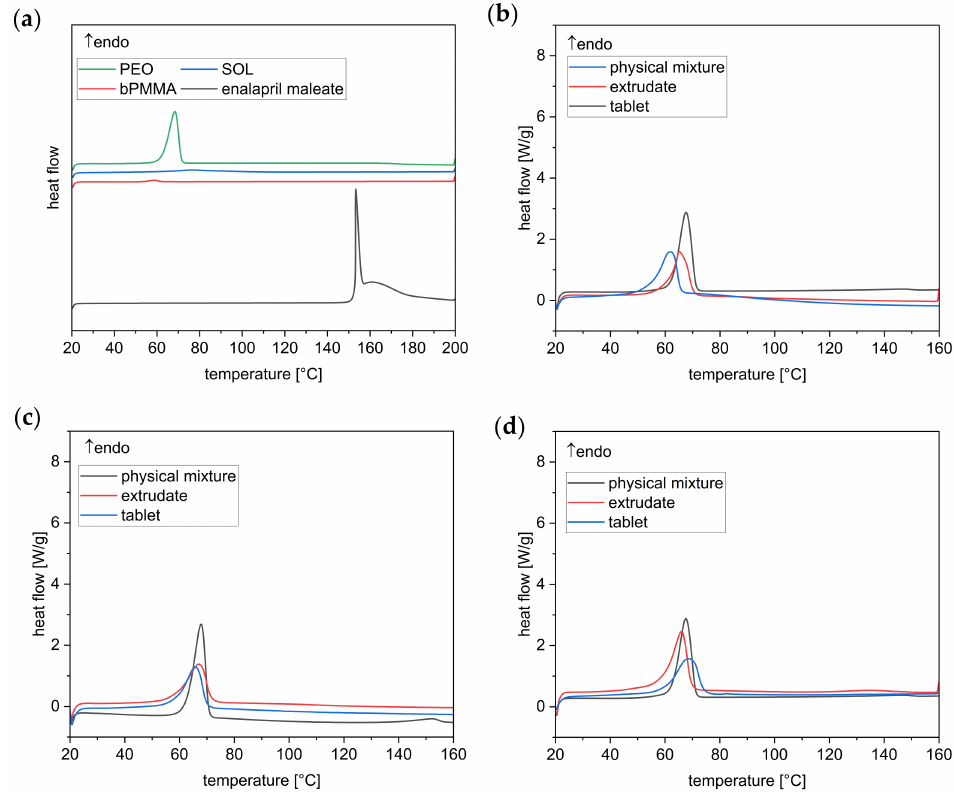
Figure 3. DSC thermograms of the starting materials ( a ), the formulation containing SOL extruded at 100 ◦ C ( b ), the formulation containing bPMMA extruded at 100 ◦ C ( c ), and at 70 ◦ C ( d ),